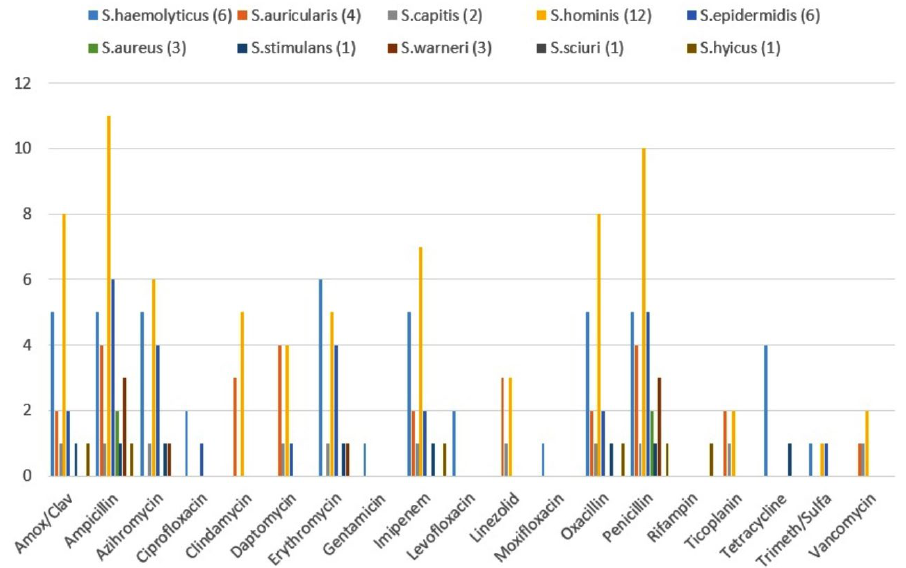
Fig. 2. Antibiotic susceptibility pattern of gram-positive